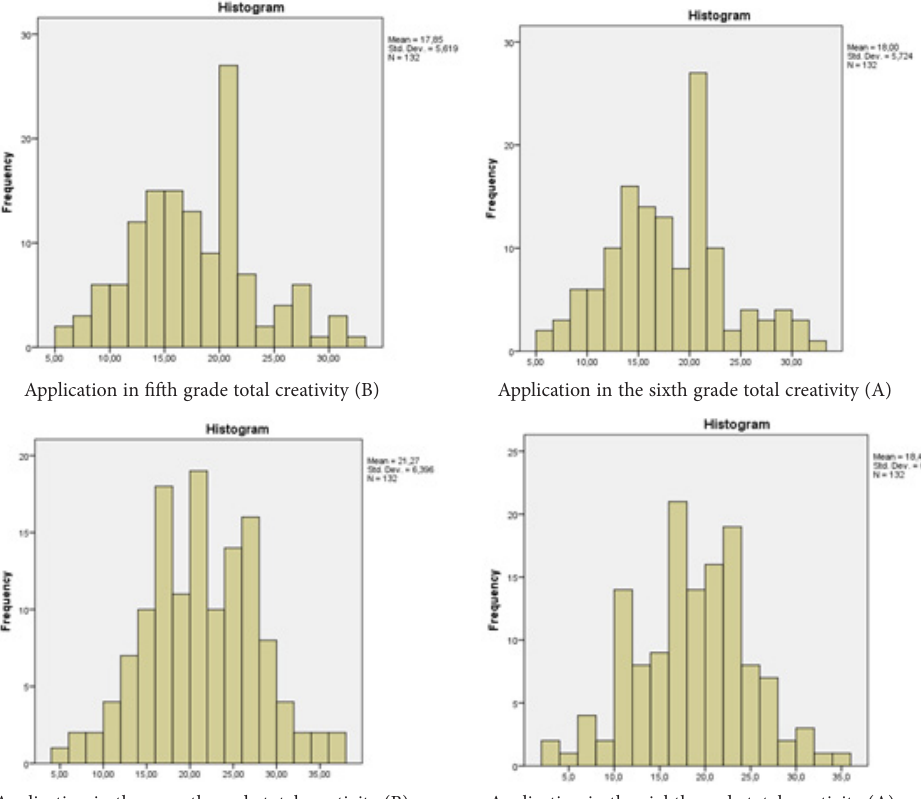
Figure 1. Histogram for the total scores of Shapiro-Wilk normality test results obtained from the fifth, sixth, seventh and eighth grade application results of Torrance Creative Thought Scale Figure Form A and Form A (source: created by